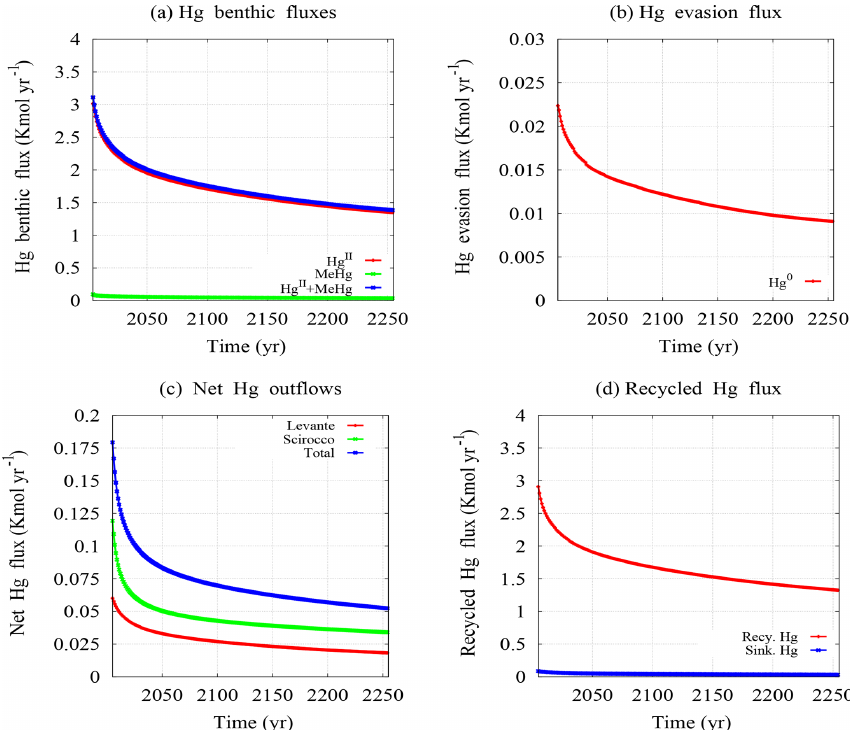
Figure 7. Mercury benthic fluxes (a) , evasion flux to the atmosphere (b) , net outflows at the inlets (c) , and recycling fluxes (d)